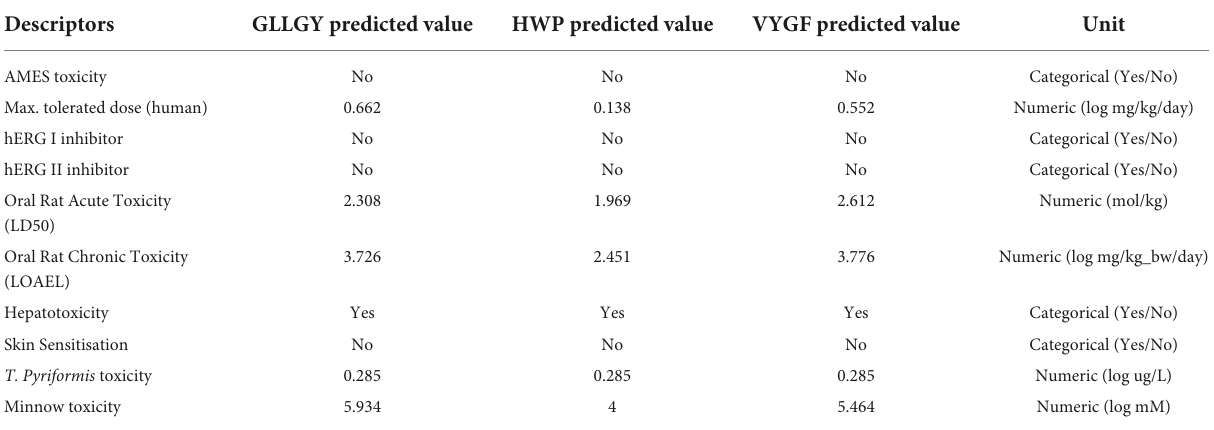
TABLE 1 Toxicity studies ( in-silico ) of oligopeptides GLLGY, HWP, and